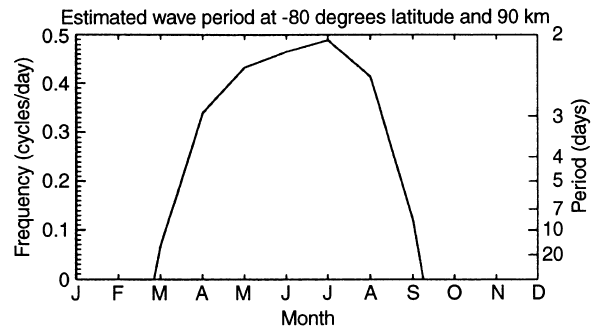
Fig. 14. The instability wave frequency assuming c (cid:136) (cid:22) U for a zonal wave number one disturbance at 80 (cid:14) S and 90km as a function